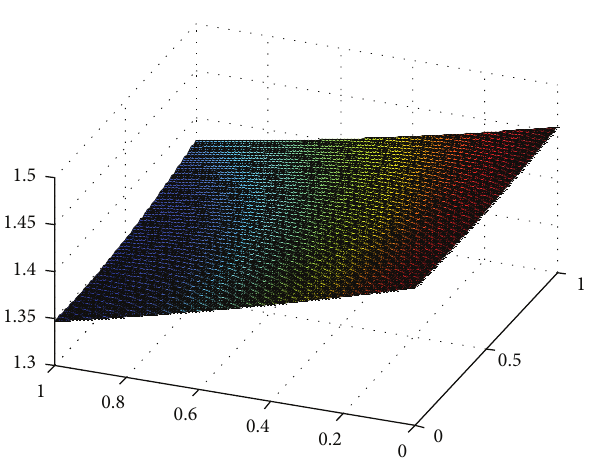
Figure 4: Representation of function (1) over a concave surface.